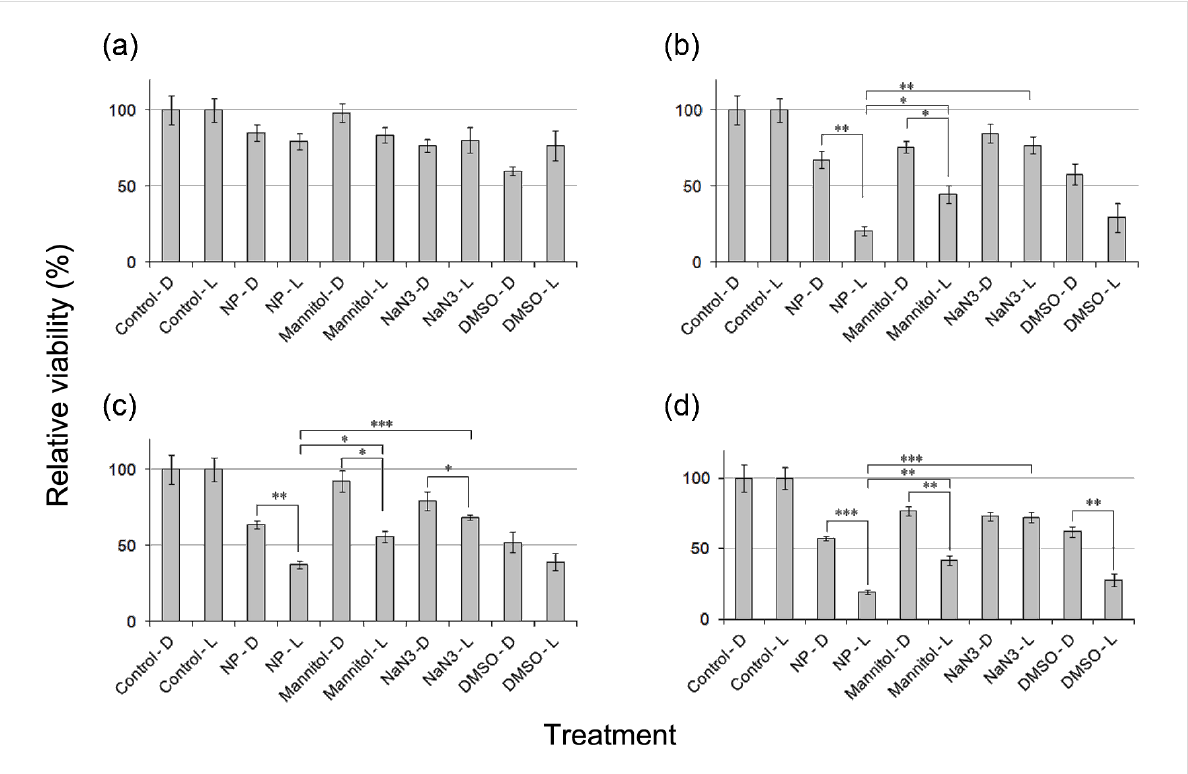
Figure 8: Effect of ROS scavengers mannitol, NaN 3 and DMSO on the photo-oxidative activity of ZnO and ZnO:Ag nanocomposites as measured by MTT assay in HT144 (skin cancer) cells. Viability (mean ± SD) was calculated relative to the NTC samples. (a) ZnO, (b) ZnO:Ag (10%), (c) ZnO:Ag (20%), and (d) ZnO:Ag (30%). * p < 0.01, ** p < 0.001, *** p < 0.0001 (two tailed